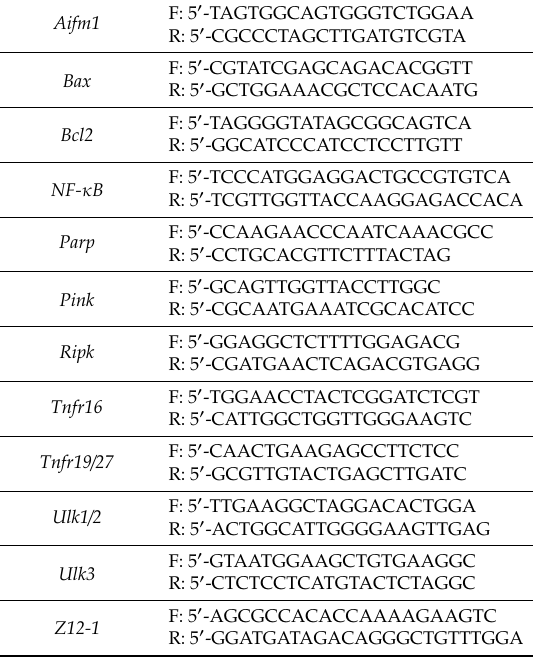
Table 3. Forward and reverse primers of 11 Paracentrotus lividus genes studied by qPCR, with Z12-1 used as reference (primers for NF- κ B are from Pinsino et al. [61], all others are from Galasso et al. [28]).